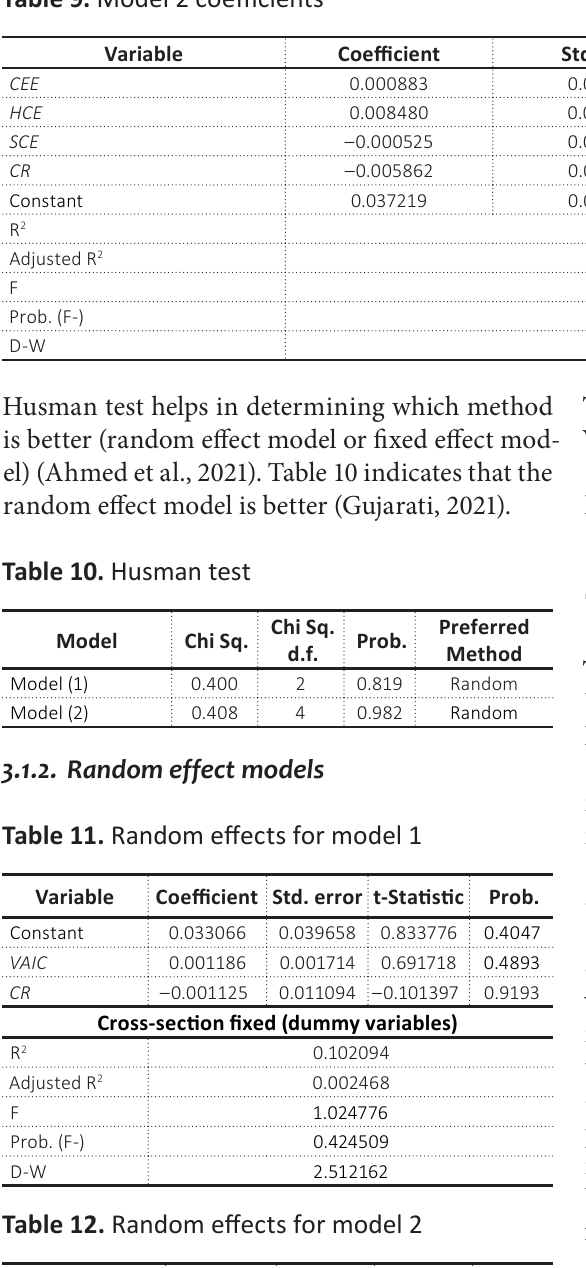
Table 9. Model 2